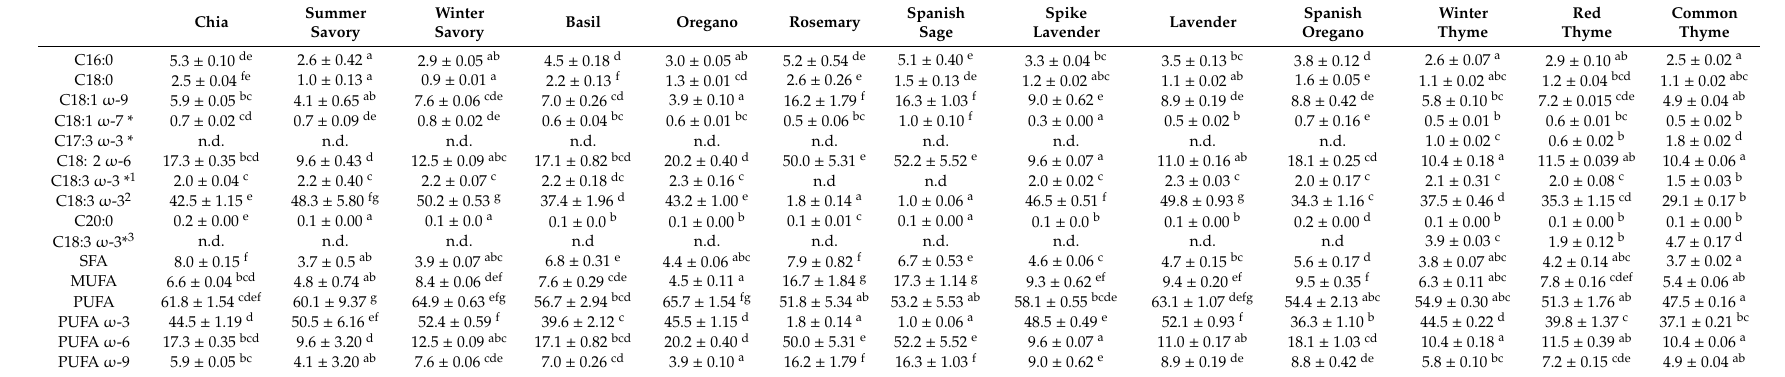
Table 1. Absolute quantitative fatty acid profile in the Lamiaceae seeds under study (g / 100 g of